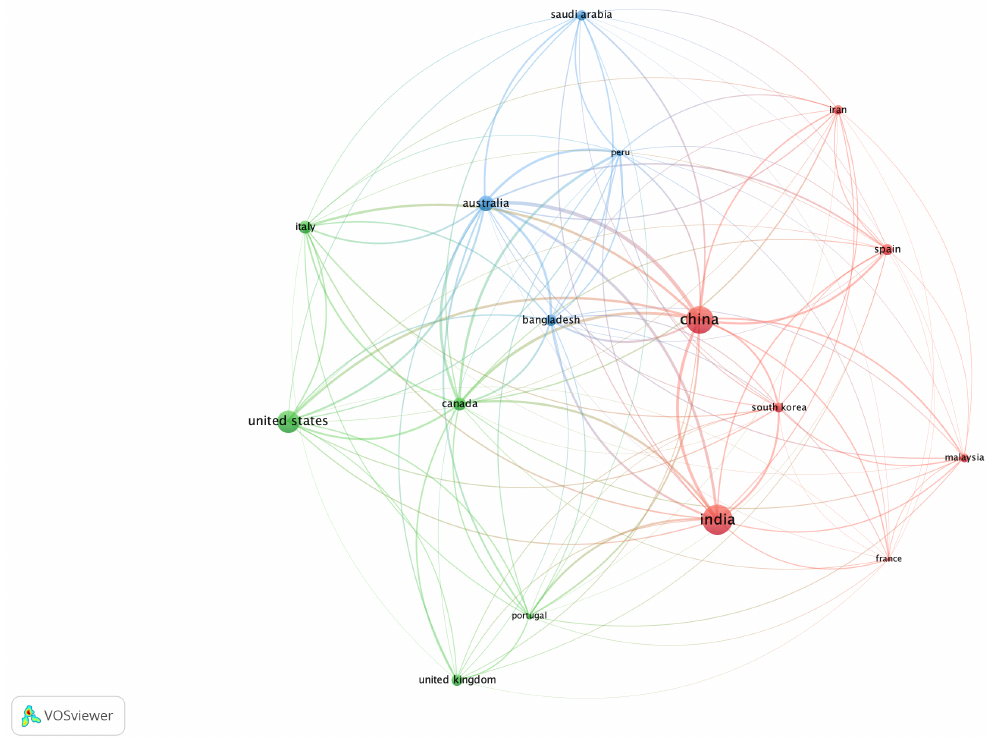
Figure 7. Network visualization of countries with greater importance in the field in terms of total